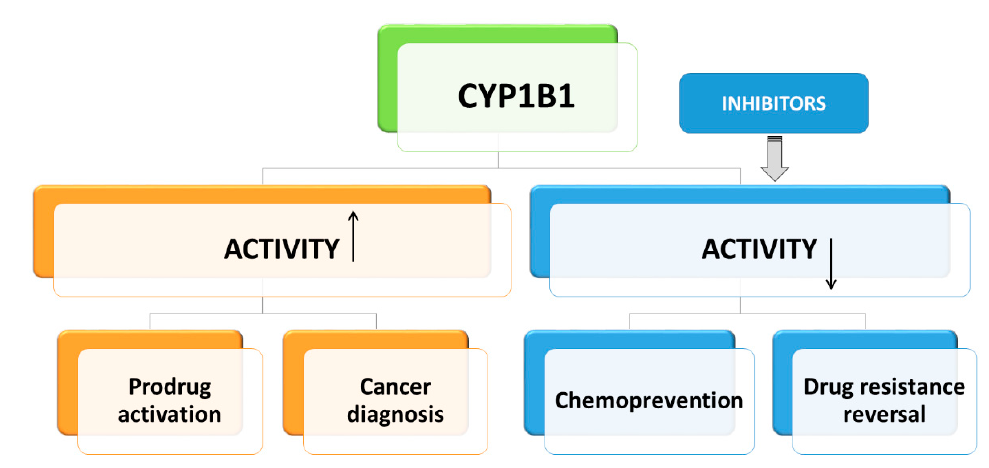
Figure 2. The role of CYP1B1 in cancer chemoprevention and